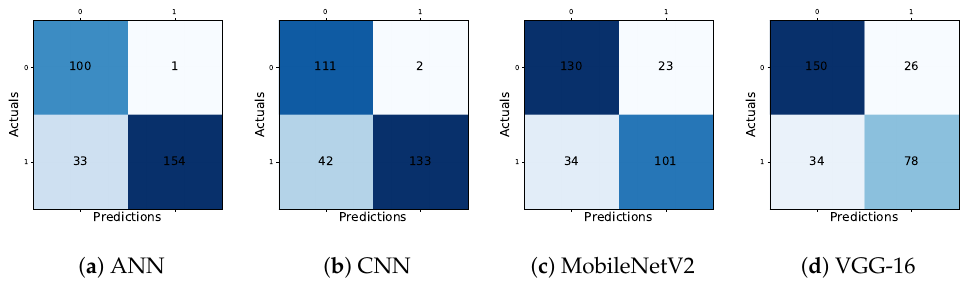
Figure 12. Confusion matrices for nutrient